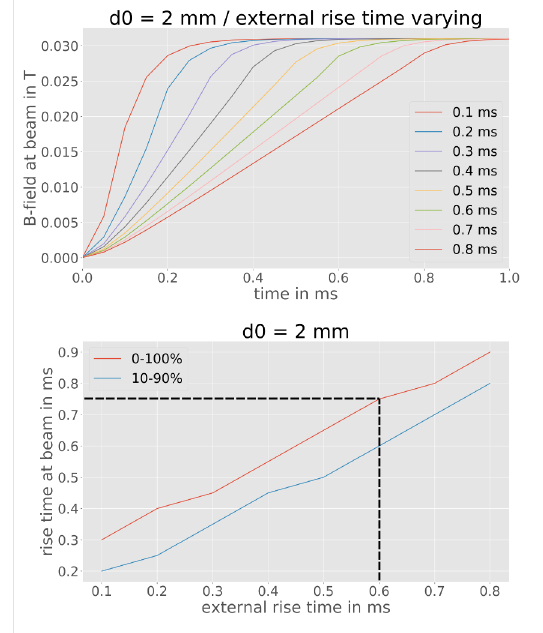
Figure 8. Evaluation of magnetic flux density rise time at beam position in the kicker magnet of the Multiplexer setup gov- erned by eddy-current induced delays from the stainless steel beam tube with d 0 = 2mm wall thickness and inner diameter d ID = 60mm. The top plot shows the magnetic flux density (y- component) time dependence at the beam position during ramp- ing of the current in the magnet with di ff erent magnet excitation rise times. The lower plot shows the rise time of the magnetic flux density at the beam position (0-100 % and 10-90 % rise time) versus di ff erent magnet excitation rise times as derived from the top plot. The dashed line indicates the magnet excitation rise time that yields 750 µ s rise time at the beam position. The mag- net is ramped up to 30mT as described in section